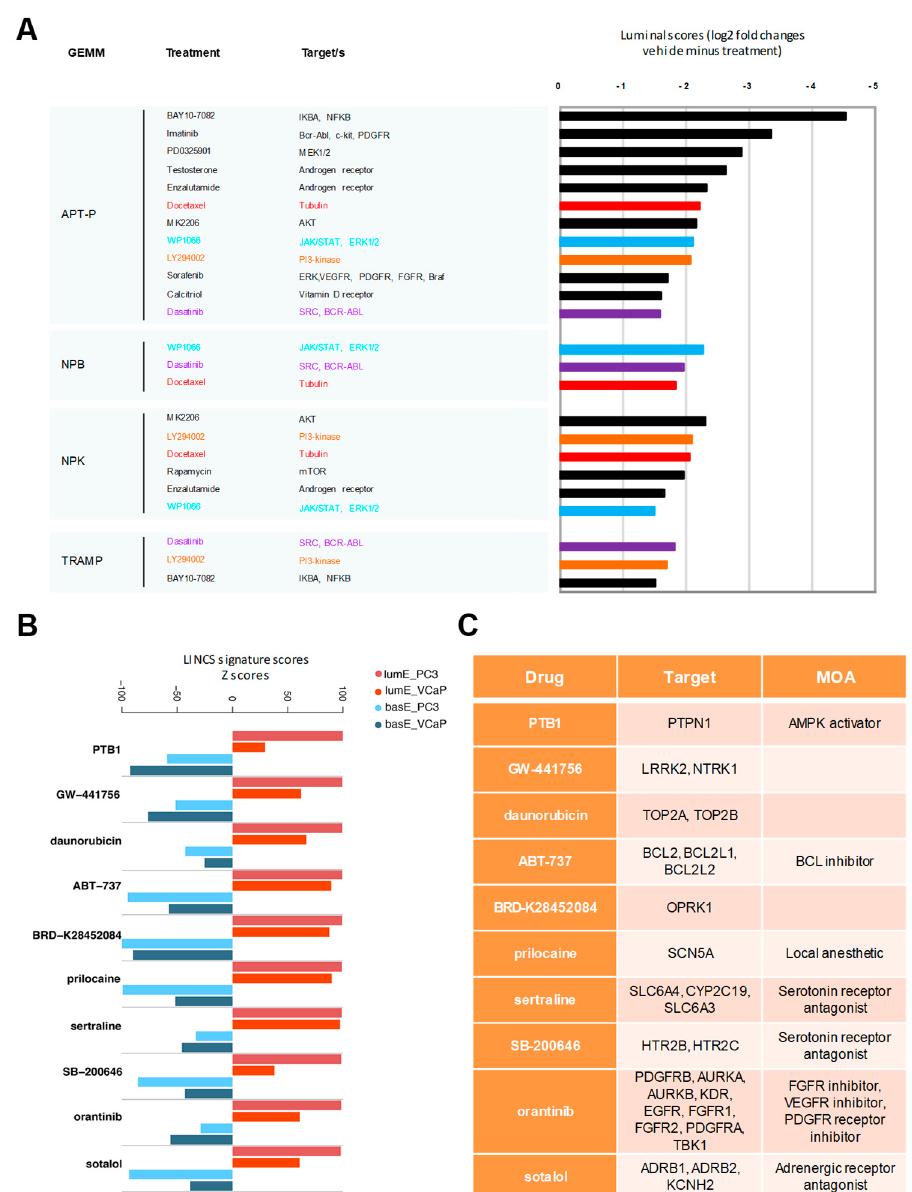
Figure 8. Identification of compounds enhancing luminal metagene enrichment. ( A ) Compounds increasing luminal metagene scores ( ≥ 2-fold change) in the indicated mouse models. ( B ) Top ranking compounds modifying luminal and basal enrichment scores consistently in VCaP and PC3 cells. ( C ) Targets and mechanism of action (MOA) of drugs enhancing luminal scores in both VCaP and PC3 cells. Library of Integrated Network-Based Cellular Signatures (LINCS) signature enrichment scores were defined by CLUE